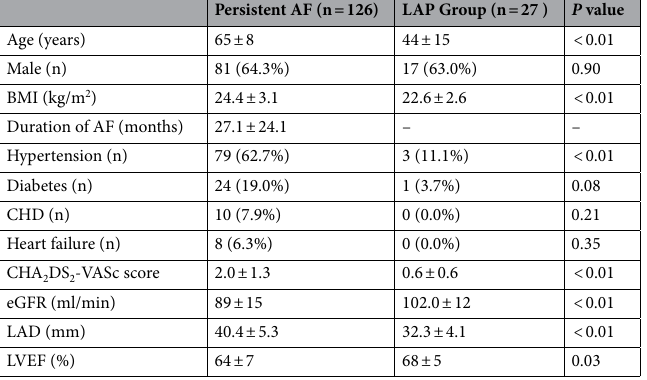
Table 1. Characteristics of participants. AF, atrial fibrillation; BMI, body mass index; CHD, coronary heart disease; eGFR, estimated glomerular filtration rate; LAD, left atrial dimension; LAP, left-side accessory pathway; LVEF, left ventricular ejection